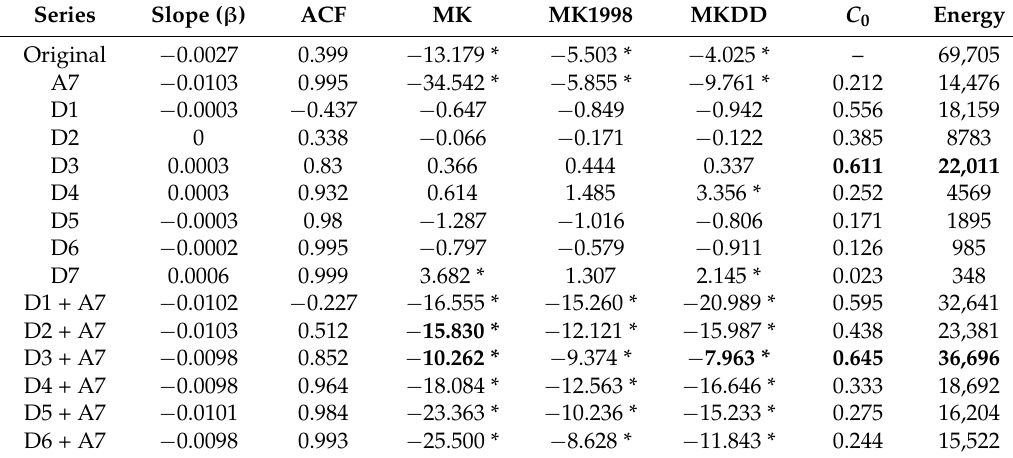
Table 4. Slope β (computed by TSA), Lag-1 ACFs, Mann-Kendall values (three MK tests) and energy